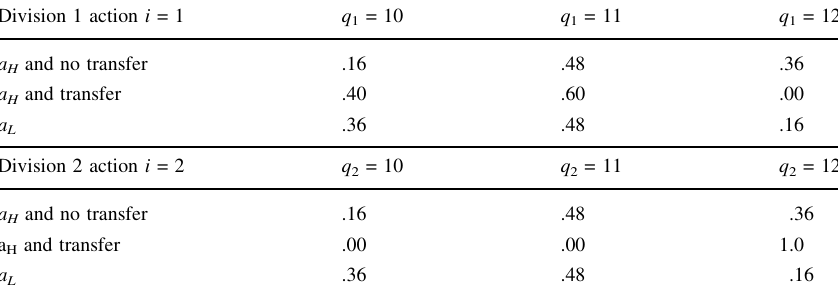
Table 1 Outcome distribution as functions of action choices